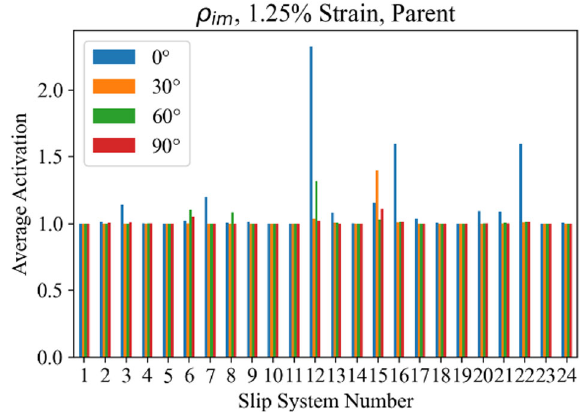
Fig. 22 Average mobile slip system activation for hydride material (fcc) at 2.0% nominal strain.